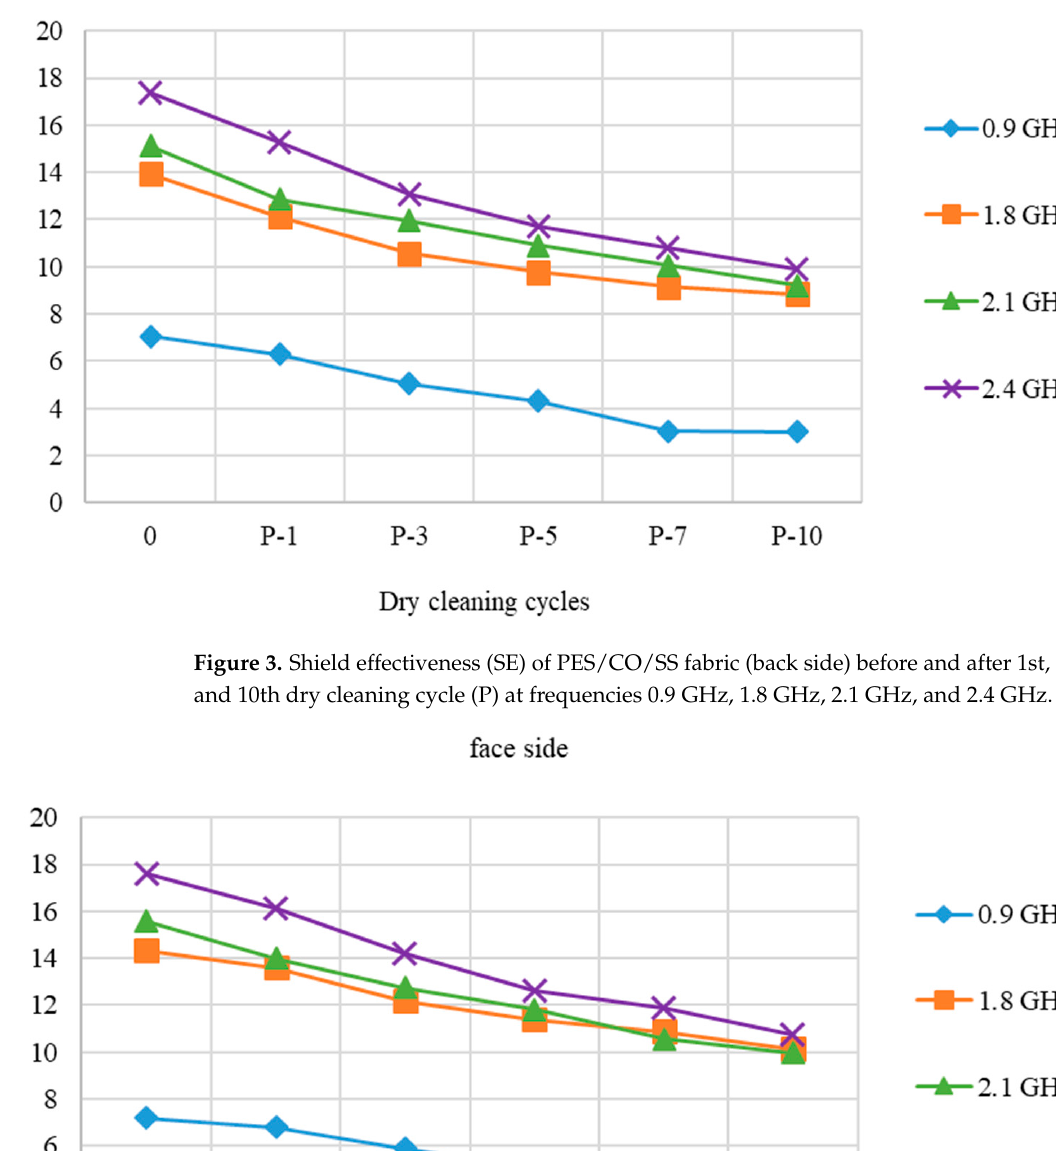
Figure 2. Shield effectiveness of PES/CO/SS fabric (face side) before and after 1st, 3rd, 5th, 7 th , and 192